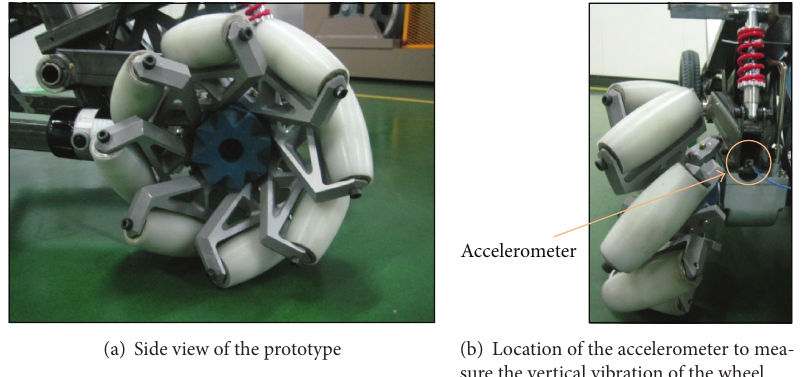
Figure 2: Prototype of the proposed mecanum wheel and sensor location for the measurement of vertical vibrations.